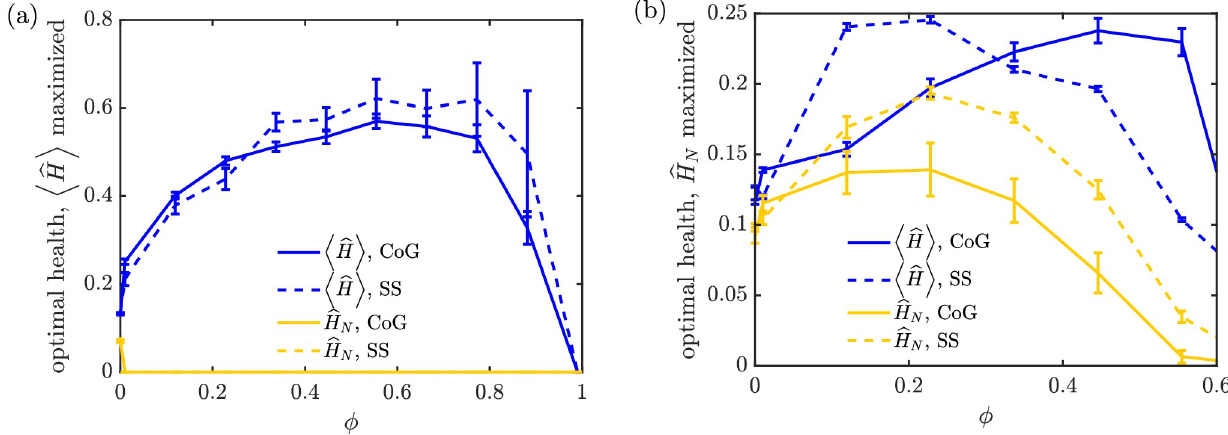
Fig 10. Optimal performance of mitochondrial maintenance models in presence of mitophagy. (a) For each mitophagy threshold ϕ , the parameters f N s are optimized to give the maximum normalized average health: h H i . The resulting normalized average health (blue) and normalized last region health (yellow) are plotted for the CoG model (solid) and SS model (dashed). (b) Analogous plots, with parameters adjusted to maximize the normalized last region health ^ H for each mitophagy threshold. All health levels are normalized by total mitochondrial content per region ( M / n ), corresponding to a n system where the total amount of mitochondrial material is limited. Error bars show standard error of the mean from 10 replicates. Fixed parameters are ^ k ¼ 0 : 6 , M = 300, n = 10. A corresponding plot of optimized health for low decay rate ^ k d